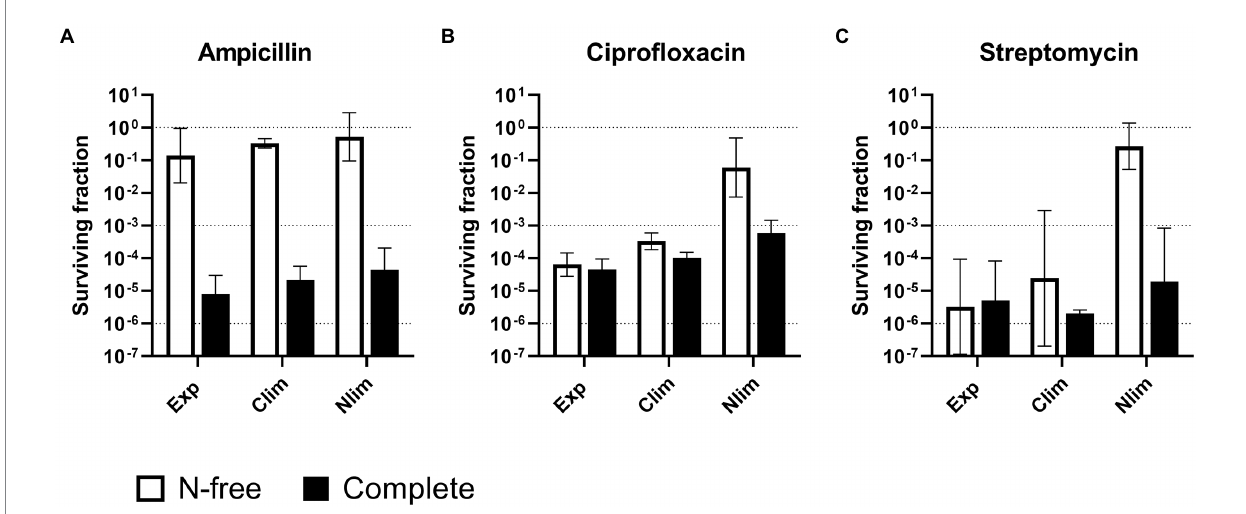
FIGURE 2 Survival of Escherichia coli WT cells pregrown to three physiological states and treated with antibiotics in two stress media. Escherichia coli WT cells were pregrown to three physiological states in benchtop bioreactors before centrifugation and resuspension into two stress media with (A) 100 μ g/ml ampicillin, (B) 5 μ g/ml ciprofloxacin or (C) 25 μ g/ml streptomycin. Viable cell counts were assayed at 0 and 5 h after treatment, and the surviving fractions at 5 h were calculated. Geometric mean and geometric standard deviation from 2 to 4 experiments are plotted, with a dotted line at 10 0 , 10 − 3 , and 10 − 6 to aid interpretation. N-free, HAS medium lacking nitrogen; Exp, exponential phase; Clim, carbon-limited stationary phase; Nlim, nitrogen- limited stationary